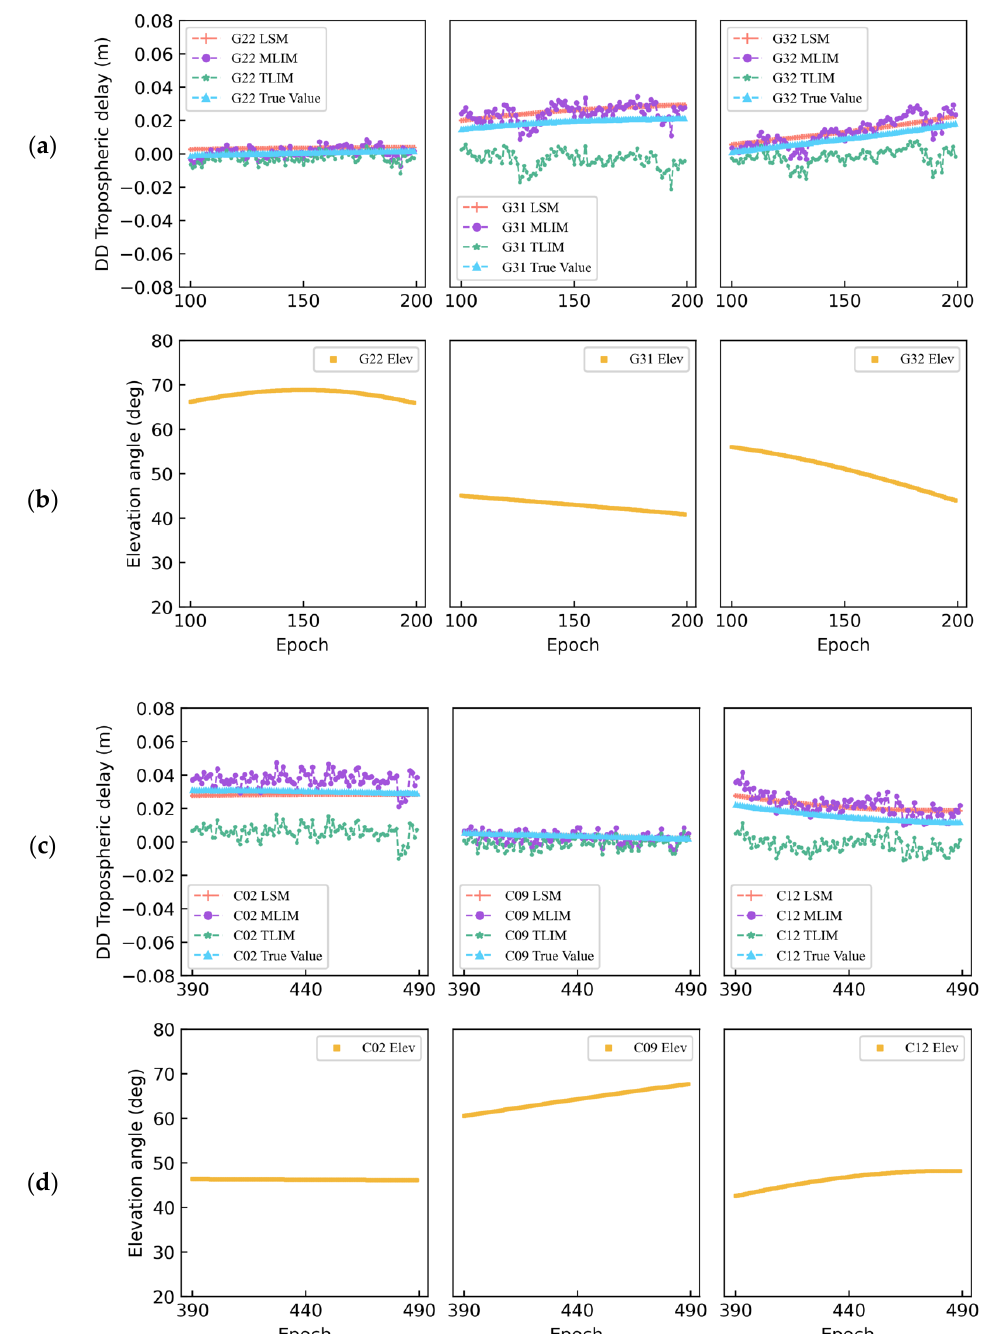
Figure 7. The satellite elevation angle variation and comparison of the DD tropospheric delay obtained by different methods with the true values for GPS ( a , b ) and BDS ( c , d ). Similarly, for all satellites in the selected period, we calculated the RMS and improve- ment ratios of the tropospheric delays interpolated using MLIM and MLSM relative to the TLIM. The results are shown in Figure 8. Here, the largest improvements under MLIM